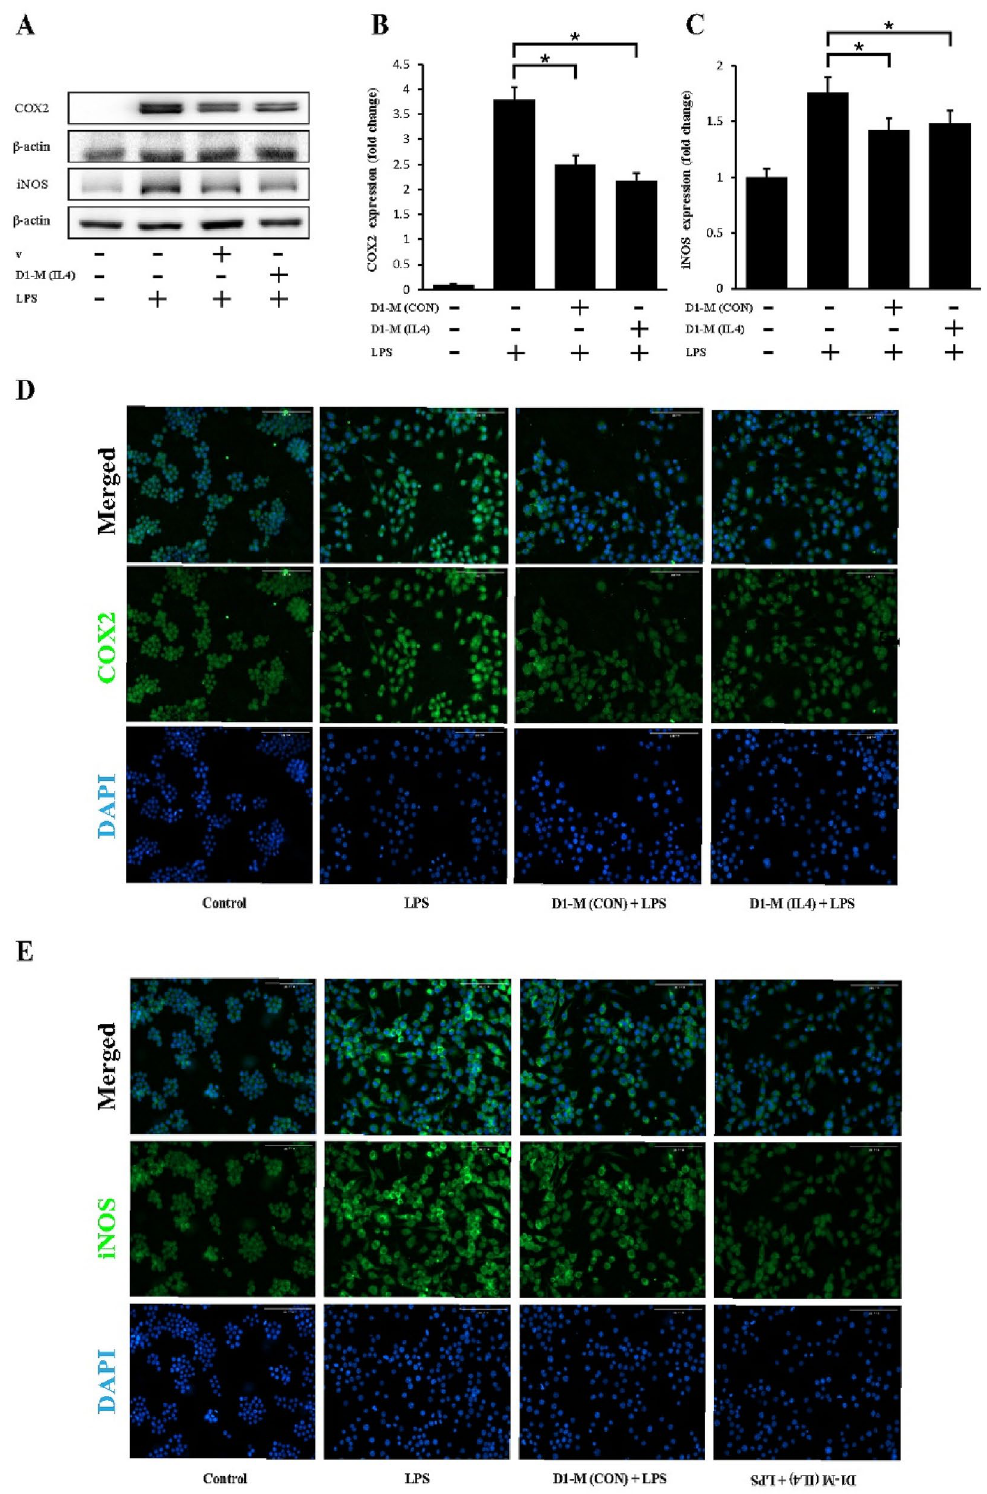
Figure 1. Mesenchymal stem cell conditioned media inhibited the LPS-induced expression of pro-inflammatory enzymes. LPS stimulation effectively upregulated the production of COX-2 and iNOS, which was reduced by pretreatment with MSC-CM ( A ). Representative western blots of COX-2 ( B ) and iNOS ( C ) expression in LPS-stimulated RAW264.7 cells with or without MSC-CM treatment for 24 h; quantitative data representing the average values of three separate experiments. Fluorescence images (× 200) of RAW264.7 cells immunostained for COX-2 (green) and DAPI (blue) ( D ) as well as iNOS (green) and DAPI (blue) ( E ). LPS treatment was performed for 6 h after pretreatment with MSC-CM. The results are representative of three separate experiments ( * P < 0.05, ** P < 0.01 compared with LPS stimulation without MSC-CM). The Fig. 1A and D were cropped to improve the clarity and conciseness of the presentation, and the full-length blots/gels are presented in Supplementary file. MSC-CM, mesenchymal stem cell conditioned media; D1-M (CON), D1 cell media; D1-M (IL4), D1 cell media stimulated with IL4; LPS, lipopolysaccharides; COX-2, cyclooxygenase-2; iNOS, inducible nitric oxide